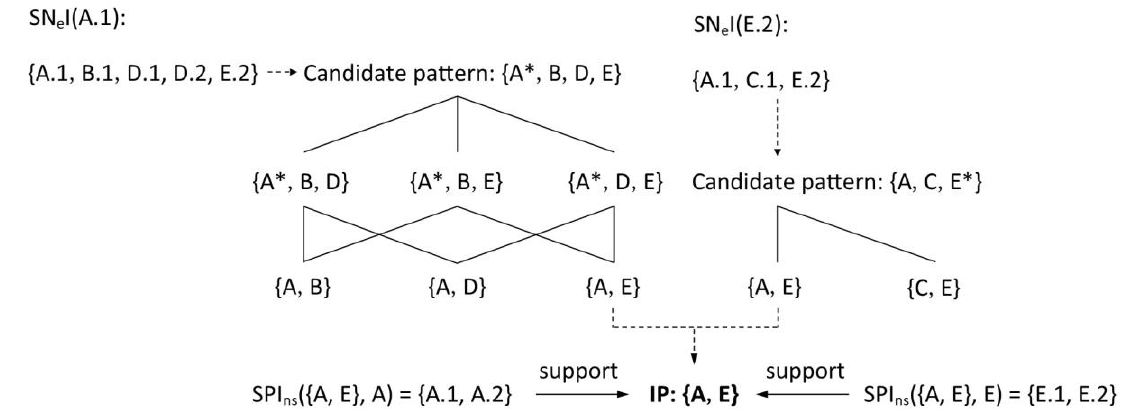
Figure 5. An example of decomposition of the unqualified patterns by a central feature to sub candidate patterns at a smaller size, based on Figure 2, where the central features of candidate patterns are marked with an * superscript to improve